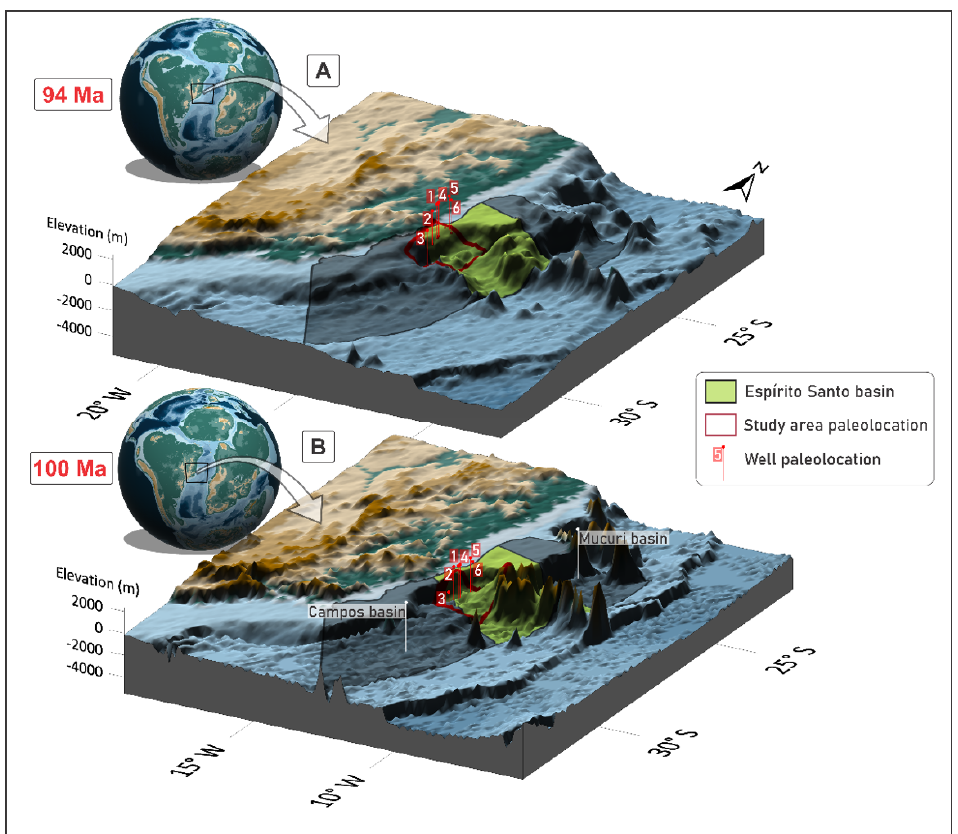
Figure 1. Paleolocations of the wells (ES-1 to 6) during the oceanic anoxic event 1d (OAE1d) ( A ) and oceanic anoxic event 2 (OAE2) ( B ) of the Cretaceous. Paleobathymetry is derived from [22].